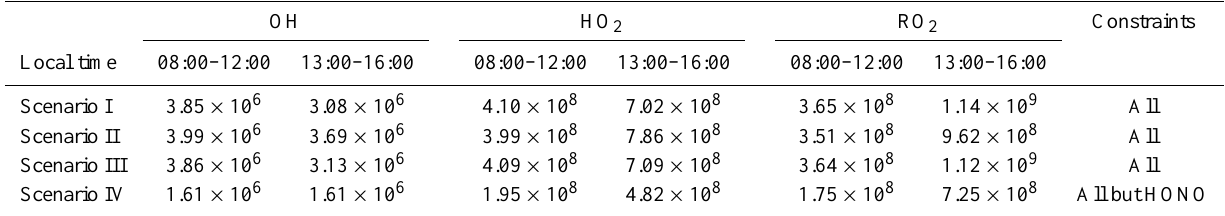
Table 4. A summary of radical distributions from the observationally constrained box-model simulation results. OH HO 2 RO 2 Constraints